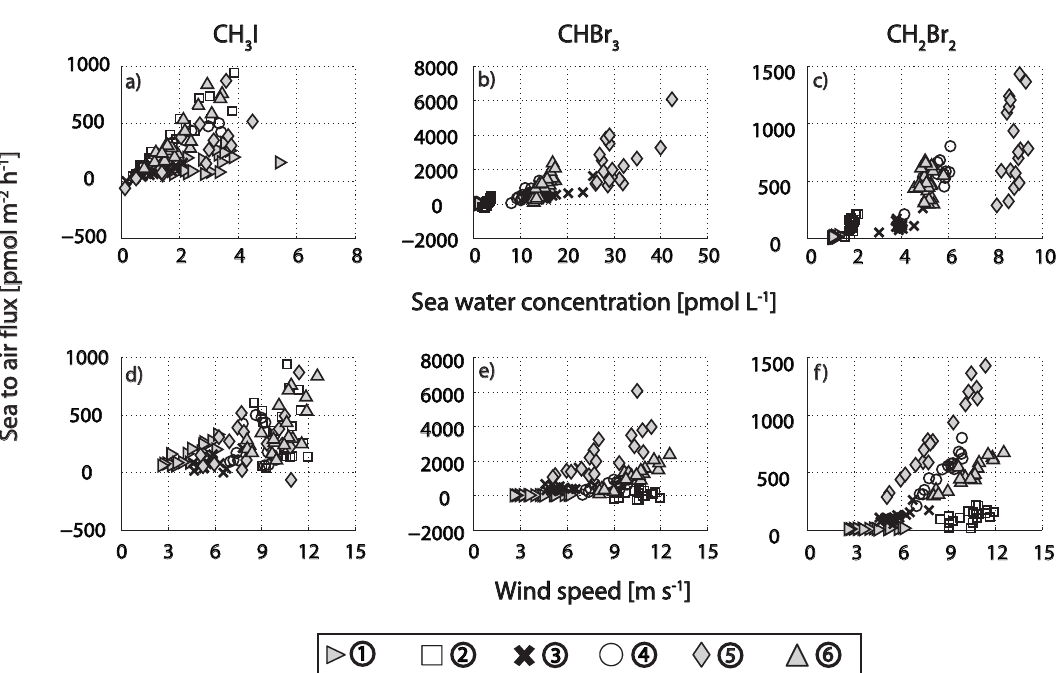
Fig. 7. Sea-to-air fluxes versus sea water concentrations of CH 3 I (a) , CHBr 3 (b) and CH 2 Br 2 (c) and wind speed (d–f) during DRIVE.